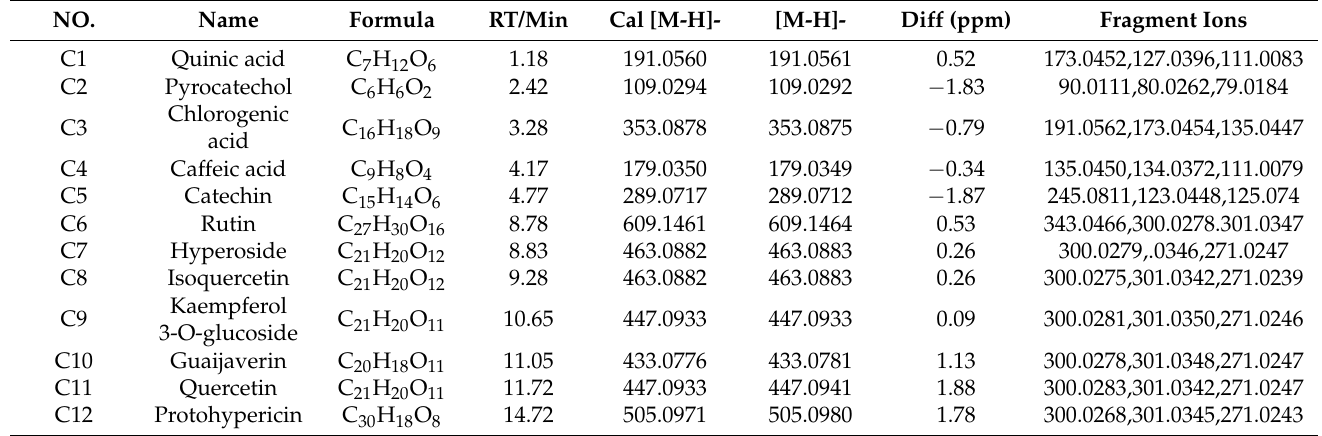
Table 2. Main chemical constituents of water extract of HP